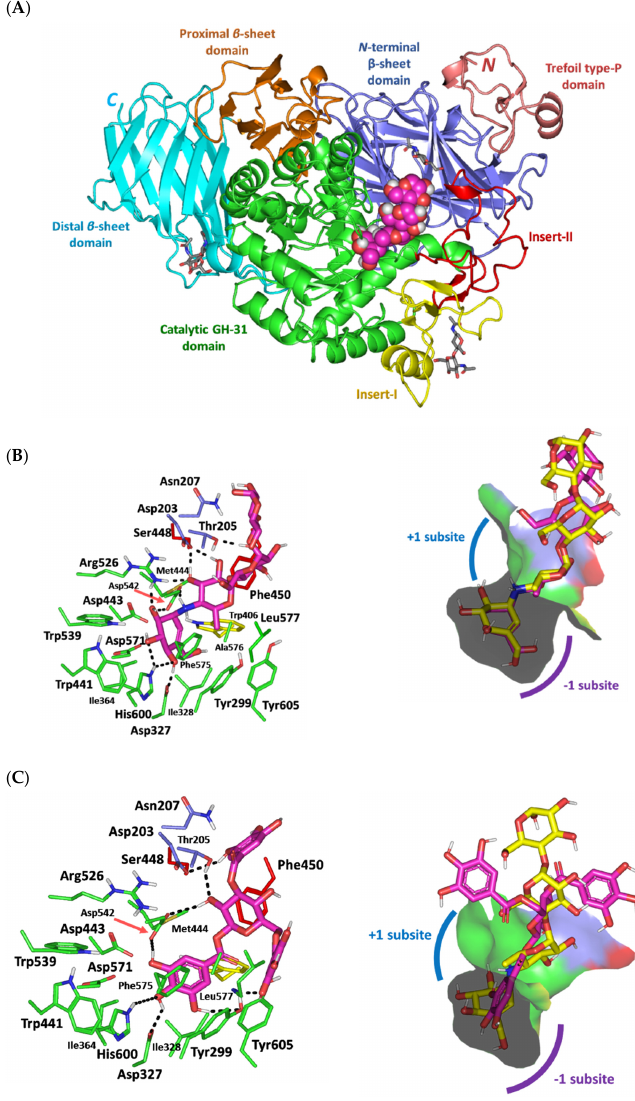
Figure 6. Architecture of the human intestinal maltase-glucoamylase α -glucosidase enzyme (hMGAM; PDB entry: 2QMJ) in complex with the co-crystalline and docked ligands. ( A ) Car- toon representation of the hMGAM in complex with co-crystalline ligand (magenta spheres)/glycan chains (grey sticks) showing the individual structural domains in different colors as follows; N- terminal trefoil P-type domain (deep salmon; residue range 1–51), β -sandwich sheet domain (slate blue; residue range 52–269), [ α / β ] 8 -barrel catalytic domain (green; residue range 270–651), with insert-I (yellow; residue range 367–416) and insert-II (red; residue range 447–492), C-terminal proxi- mal domain (orange; residue range 652–730), and distal domain (cyan; residue range 731–868). Left panels of ( B , C ) are the predicted binding modes of the redocked acarbose and C. oblongifolia isolated 1,3,6-trigalloylglucose (magenta sticks), respectively, at the hMGAM shallow substrate-binding site. The protein target is represented as a cartoon, while as, only residues located within a 4 Å radius of bound ligand are displayed as lines, labeled with sequence number, and colored according to their structural domain location. Polar interactions, represented as hydrogen bonds, are illustrated as black dashed lines. Right panels of ( B , C ) are the overlay of each docked ligand (magenta sticks) in relation to the co-crystallized ligand (yellow sticks) within the hMGAM substrate-binding shown in surface representation. The − 1 and +1 carbohydrate subsites are depicted with purple and blue arcs,